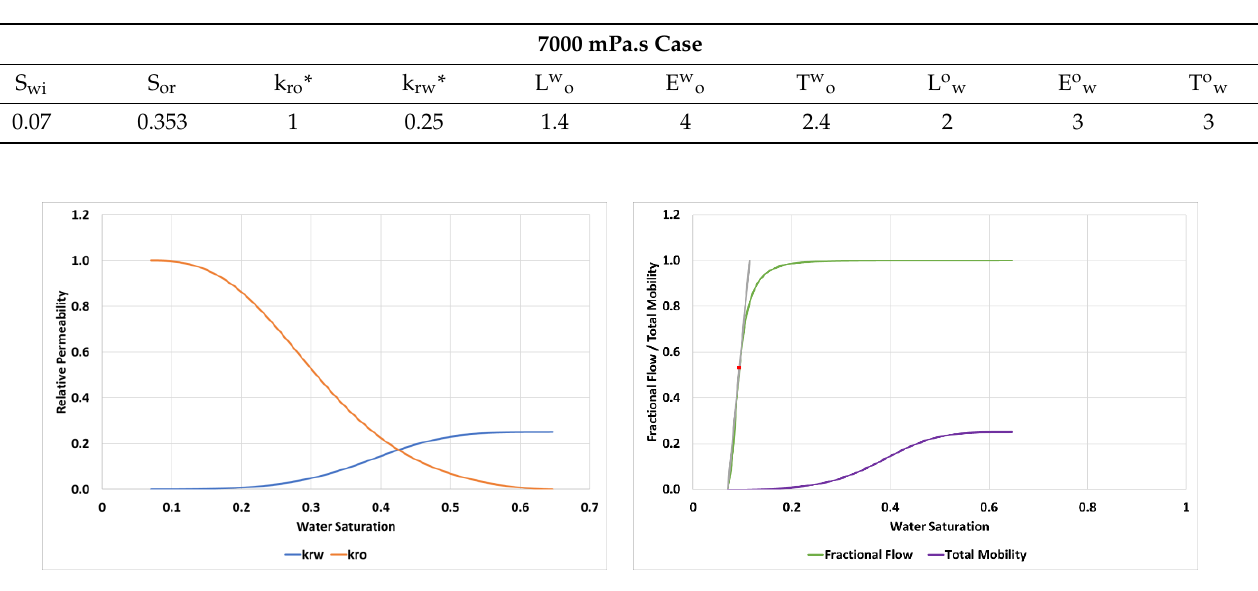
Figure 9. Demonstration of the impact of the low water saturation threshold on the visualised finger patterns.